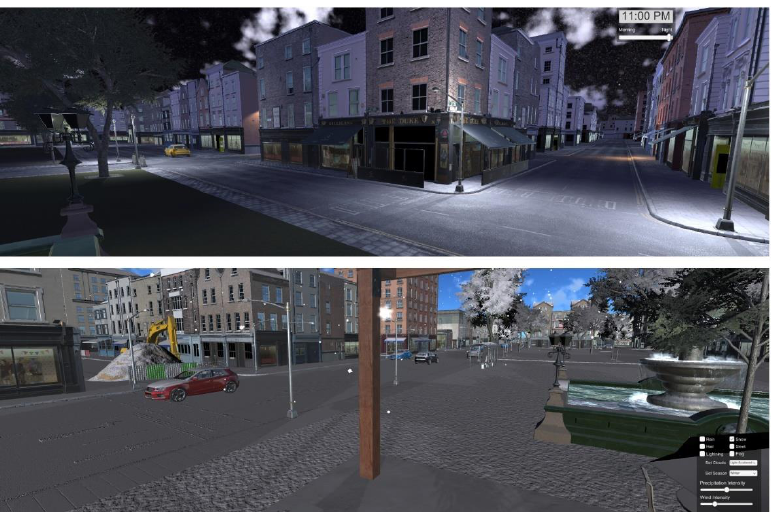
Figure 2. ( Top ): User can manipulate the time of the day via the time slider. Changing time affects how the environment looks and sounds due to the change in people and traffic in the city square, based off the behaviour settings of each sound source. Cities are dynamically lit after sundown. ( Bottom ): A weather module can help plan for different contexts, including seasons and weather conditions like precipitation, cloud coverage, and wind intensity. By changing to winter, snow is dynamically added to surfaces and the daylight hours will change due to the sun cycle changing with time of year, in respect to the city’s selectable latitude and longitude.